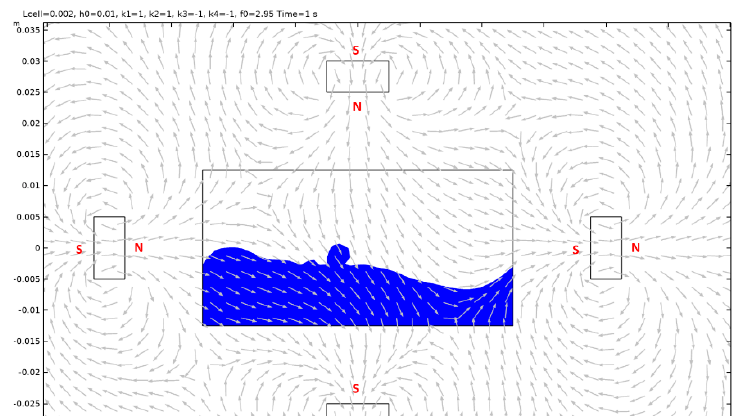
Figure A28. Case 14.